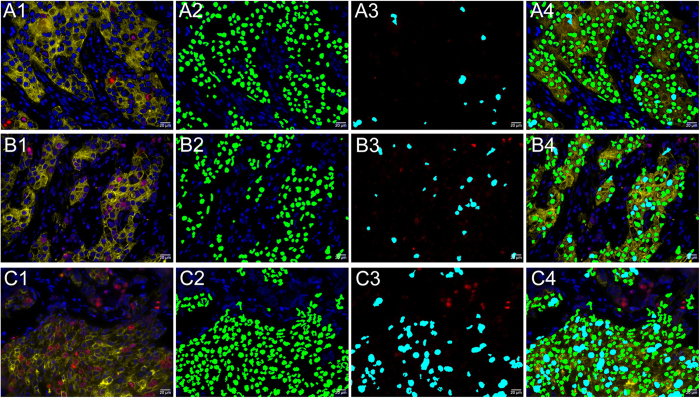
Typical examples of different Ki67 indexes counted by computerized method.Original images, recognized images of cancer cells, recognized images of Ki67-positive cancer cells, and merged images of recognized cancer and Ki67-positive cancer cells for BC with Ki67 low grade (A1–A4), moderate grade (B1–B4), and high grade (C1–C4). (Magnifications: 400×).